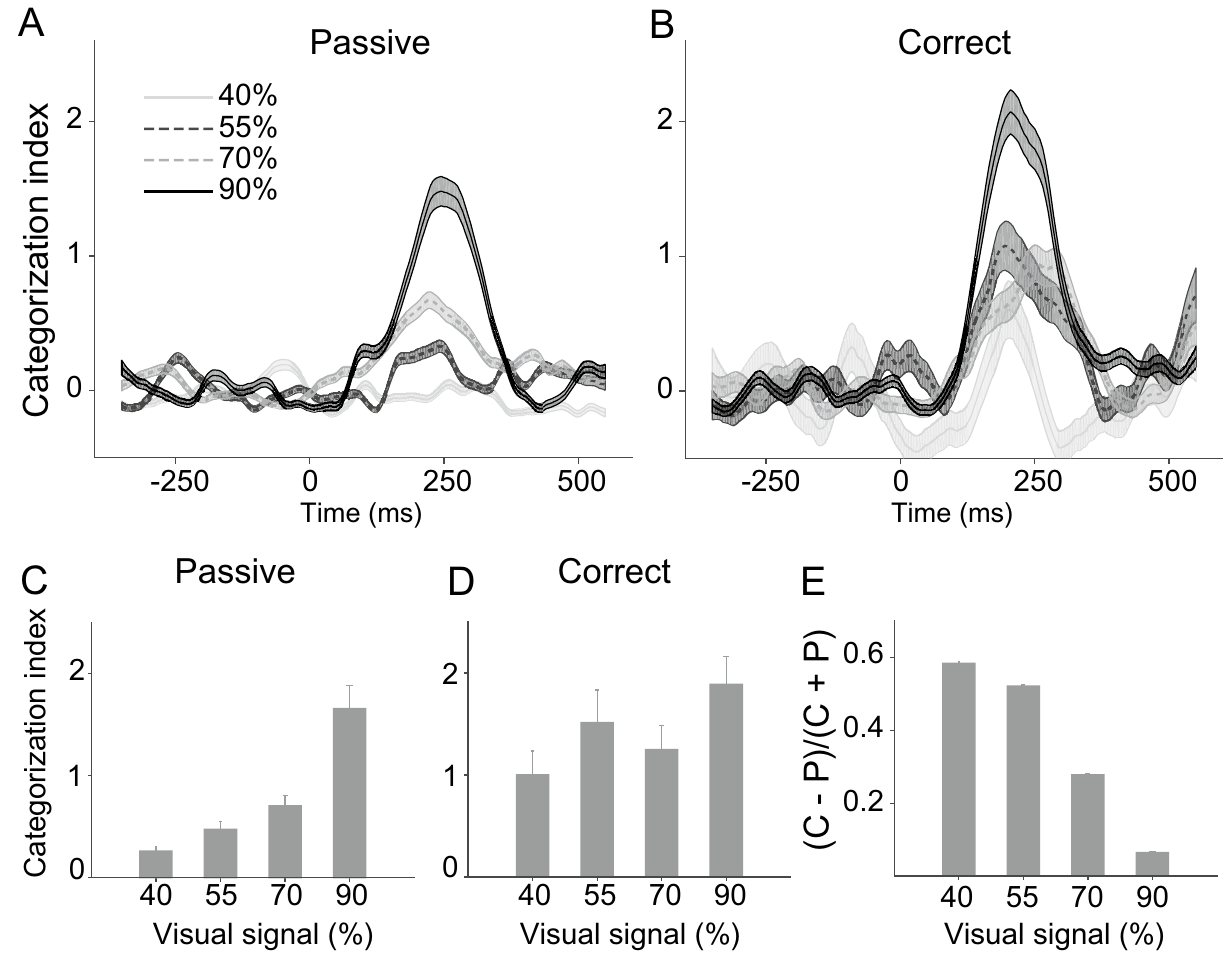
Figure 3. Category information of body-selective neural population in different stimulus noise levels and task conditions. Time course of category information in passive ( A ) and correct ( B ) trials in different signal levels. Data points are plotted in the middle of each bin. Bar graphs illustrate the CI during 150 to 350 ms after stimulus onset in passive ( C ) and correct ( D ) trials. ( E ) Category information in the correct trials compared to passive trials. Error bars represent the STD of bootstrap